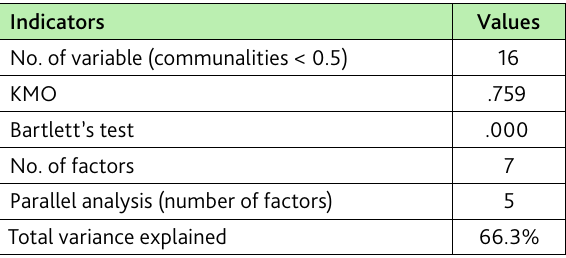
Table 5. PCA indicators for Slovenia